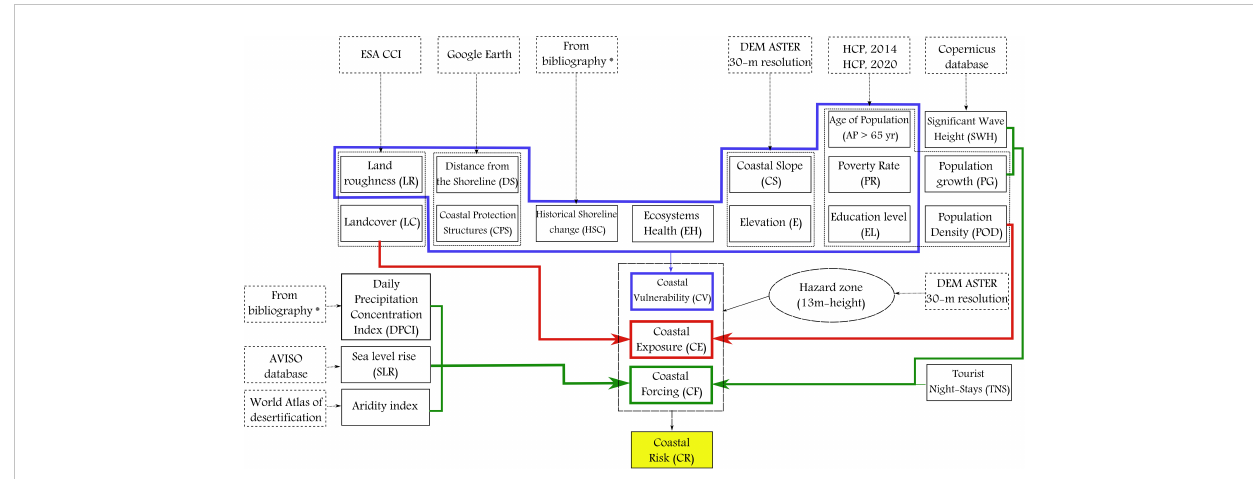
FIGURE 2 Flowchart illustrating the materials and method used to calculate the coastal risk index. *Bibliography used to produce both HSC and DPCI is mentioned in (Table